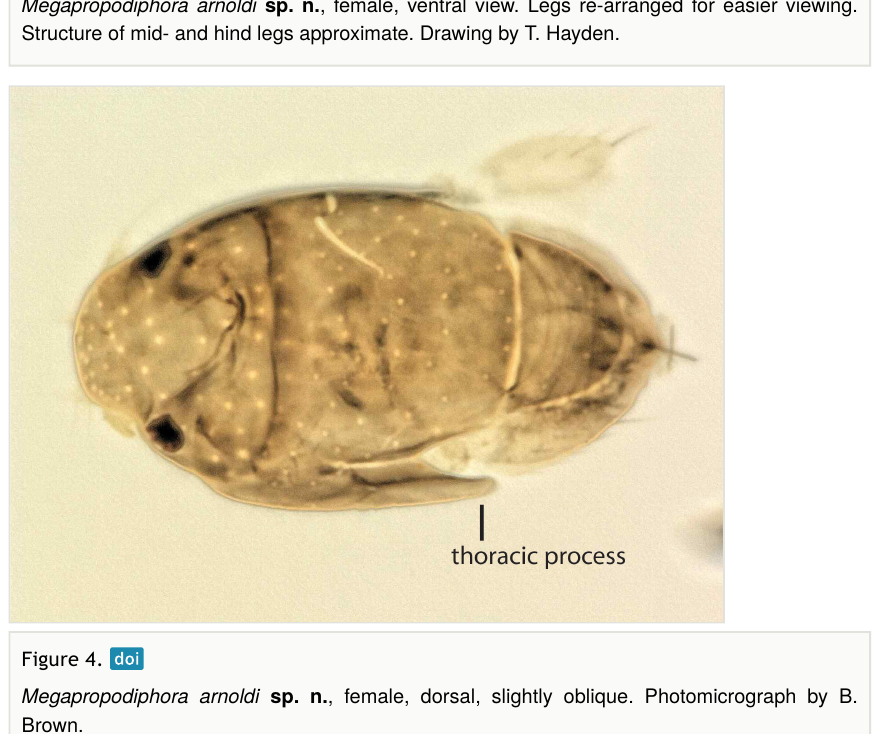
Similar genera. Males of Brachycosta Prado, 1976, have a short costa, but much longer than that of Megapropodiphora gen. n., are much larger in size and have a larger frons and head. Females of this new genus are di ff erentiated from all other phorids by minute size, leg structure and elongation of the scutellum to cover the abdomen.